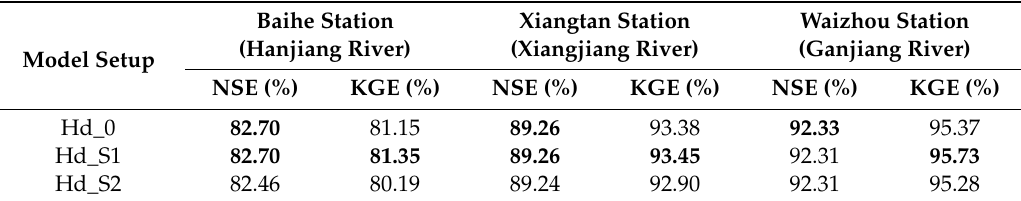
Table 3. Model performance, in terms of NSE and KGE, for the calibration period. The bold values indicate the best performance.